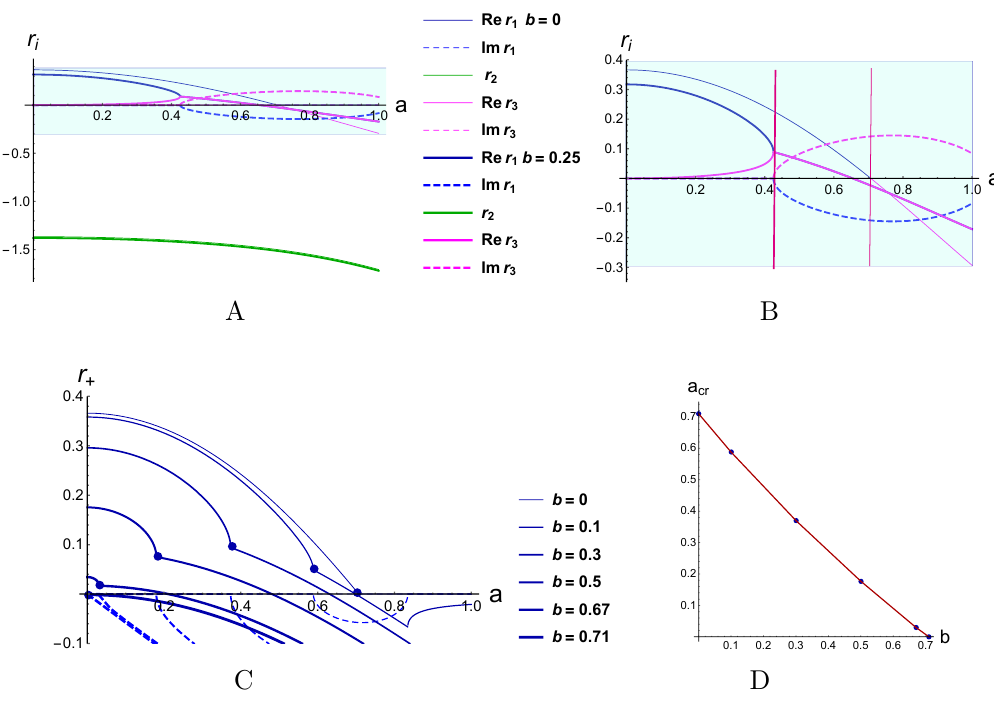
Figure 2 . A) 3 roots of equation ∆( r ) = 0 vs a for b = 0 (thin lines) and b = 0 . 2 (thick lines). Dashed line shows the imaginary part of the first root r + . B) First two roots for the same values of b = 0 , 0 . 2 . C) The first root vs a for variety of b . We see that only for a < a cr ( b ) the root r 1 √ is positive, a cr (0) = 1 / 2 . D) The dependence of critical points of a cr on b . Here M is taken to be 0 . 25 and ‘ = 1